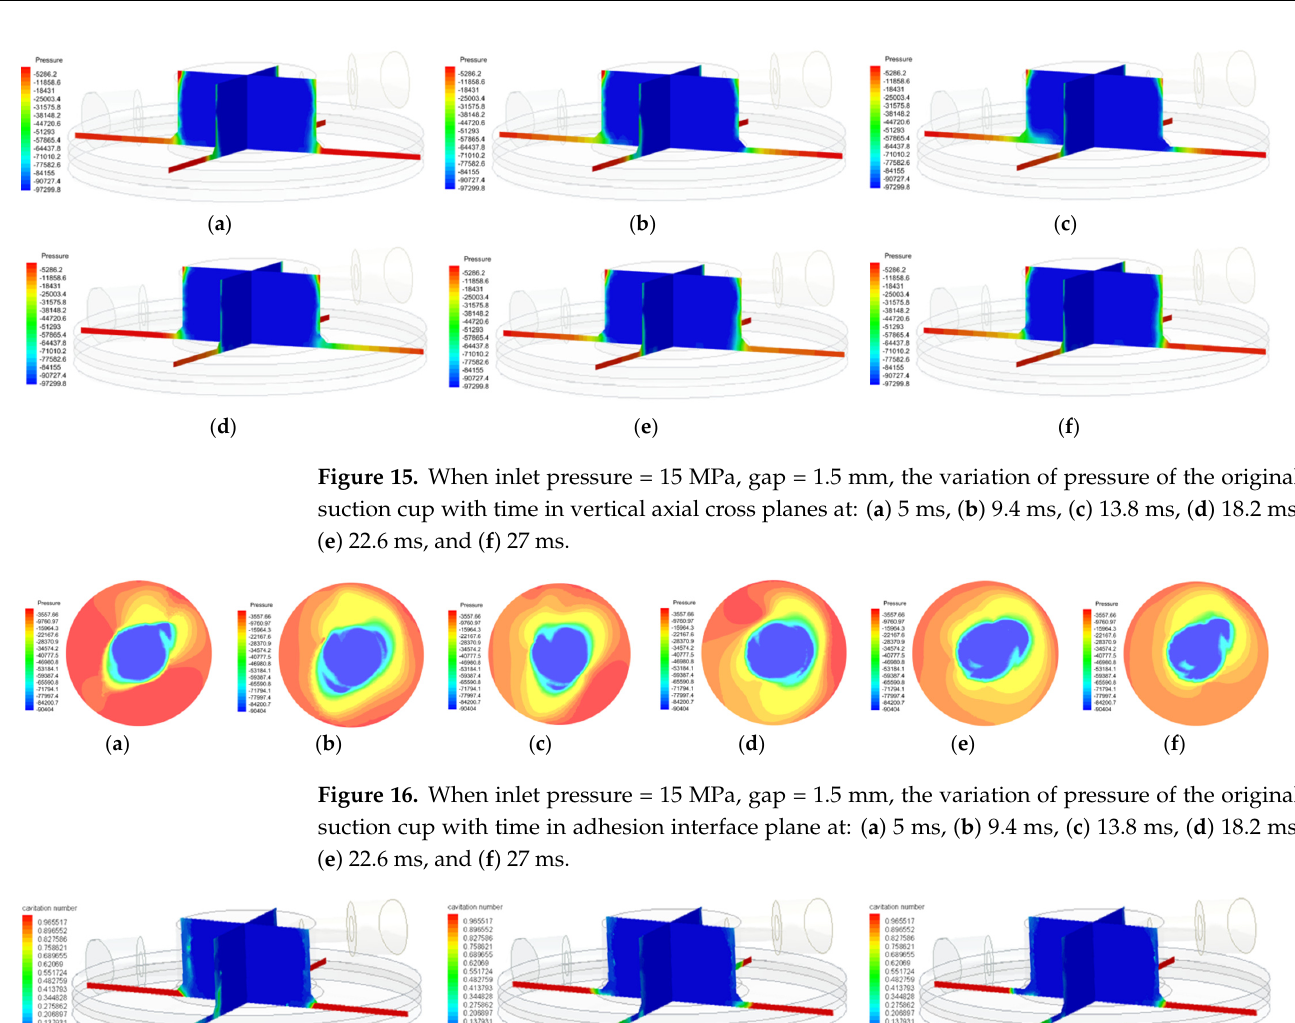
original suction cup with time in adhesion interface plane at: ( a ) 5 ms, ( b ) 9.4 ms, ( c ) 13.8 ms, ( d ) 18.2